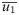
Identification of independent components that determine burst patterns.(A) The average value of 2-spike burst ISIs and the average values of 3-spike bursts u1 and u2 were determined for each event. (B, C, E, and G) Data from the cell shown in Fig 1. (B) Dependence of 2-spike burst ISIs on 3-spike burst patterns. Each dot represents an event in which the cell generated both 2- and 3-spike bursts. The horizontal and vertical axes are the averages of u1 and u2 of 3-spike bursts in an event, respectively. The color indicates the average ISI of 2-spike bursts. The arrow shows the direction of the steepest gradient of 2-spike burst ISIs. (C) Trial-to-trial variations of u1 and u2 in each event. Each dot represents a 3-spike burst. u1¯ and u2¯ represent the average u1 and u2 in each event. Dots with the same color are bursts in the same event. The yellow and green lines indicate the orientation of the principle components with the smaller and larger variances, respectively. The lengths represent the SD along the axes (compare with Fig 4E). (D) Population analyses for n = 41 cells. Each dot represents a cell. (Magenta) The direction of the steepest gradient of 2-spike burst ISIs, determined as in (B). (Yellow and green) Principle axes of the trial-to-trial variations of u1 and u2, determined as in (C). The yellow color shows the axis with the smaller variance. Straight and curved lines indicate the circular average and SD, respectively. (E) Distribution of u1 and u2. Each dot represents a 3-spike burst. Dots with the same color are bursts in the same event. The yellow and green lines are the principle axes shown in (C). θ represents the angle between the u1 axis and the principle axis with the smaller variance (yellow line). The approximately independent components w1 and w2 are shown (compare with Fig 4E). (F) Stimulus sequences encoded by the independent components w1 and w2. For each cell, the deviation from 3-BTA were calculated by subtracting 3-BTA from the average stimulus sequence preceding 3-spike bursts with the burst phase within the range centered by θ (for w1) and θ + 90° (for w2). The thick lines indicate the deviation from 3-BTA averaged across 19 cells that generated at least 1200 3-spike bursts (yellow: w1; green: w2). The thin lines show SEM values calculated across the cells. (G) The axes and circle in (E) are plotted on the ISI1–ISI2 plane. (H) The stimulus was projected onto the stimulus feature encoded by w1. sw1,3-spike was defined by collecting the values at the time points of all 3-spike bursts and normalizing them to have a mean = 0 and a SD = 1. The dashed line shows P(sw1,3-spike) averaged for the 19 cells. The thin lines indicate the SEM calculated across the cells. The colored thick lines are the probability distribution of sw1,3-spike at the time points of 3-spike bursts with a small, medium, and large w1, i.e., P(sw1,3-spike|w1<−2), P(sw1,3-spike|−0.5≤w1<0.5), and P(sw1,3-spike|2≤w1), respectively, averaged among the 19 cells. The thin lines show the SEM calculated across the cells. (I) Similar to (H), showing P(sw2,3-spike), P(sw2,3-spike|w1<−2), P(sw2,3-spike|−0.5≤w1<0.5), and P(sw2,3-spike|2≤w1). (J) Similar to (H), showing P(sw1,3-spike), P(sw1,3-spike|w2<−2), P(sw1,3-spike|−0.5≤w2<0.5), and P(sw1,3-spike|2≤w2). (K) Similar to (H), showing P(sw2,3-spike), P(sw2,3-spike|w2<−2), P(sw2,3-spike|−0.5≤w2<0.5), and P(sw2,3-spike|2≤w2). ~1.5% of bursts are out of the range of the plot in (C), (E), and (G).